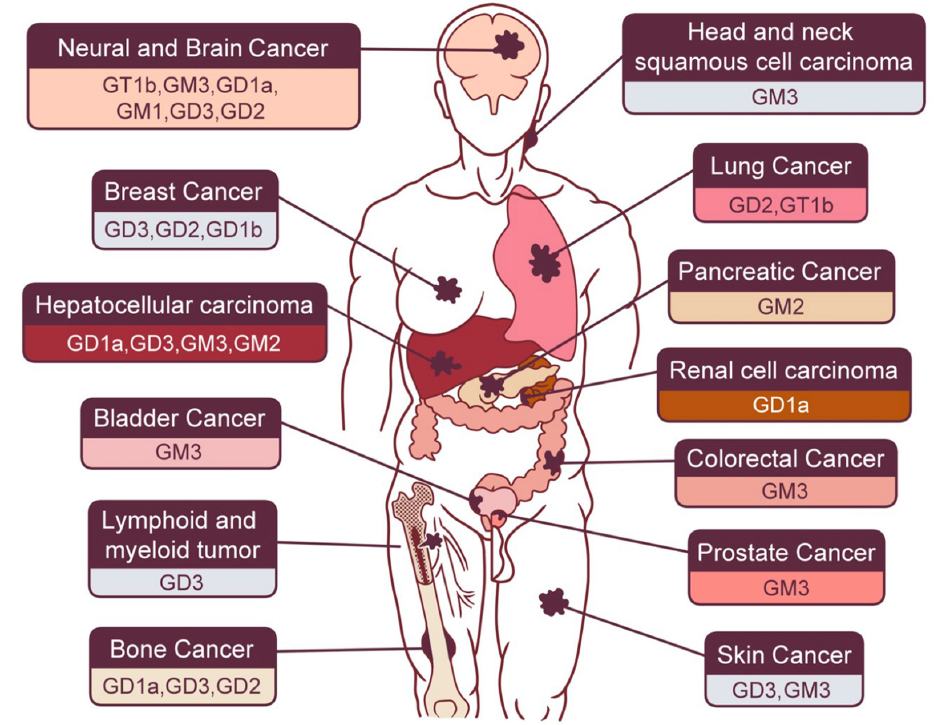
Int. J. Mol. Sci. 2021 , 22 , x FOR PEER REVIEW Figure 2. Each species of cancer in the human body and related gangliosides as described in this text.